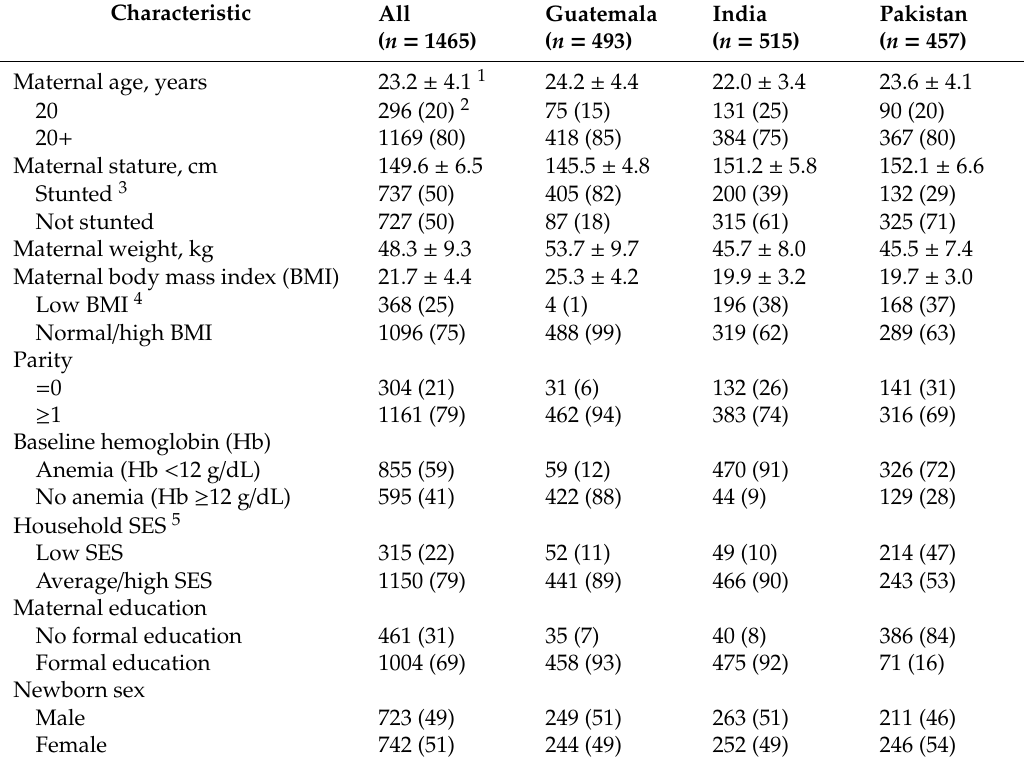
Table 1. Maternal characteristics, newborn sex, and risk factors by site.